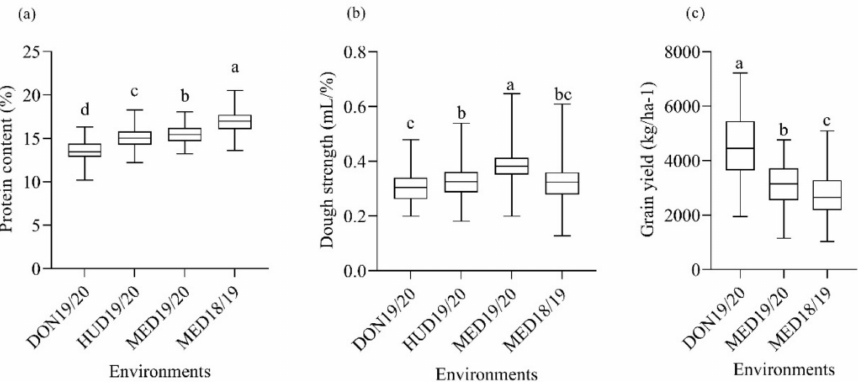
Figure 2. Box plot of ( a ) mean protein content, ( b ) dough strength, and ( c ) grain yield of multiple synthetic derivative lines grown under optimum (DON19/20), moderate heat-stress (HUD19/20), and continuous heat-stress (MED18/19 and MED19/2020) conditions. Box plots with similar lower- case letters indicate that the means for the trait are not significantly different according to the Tukey test at p <